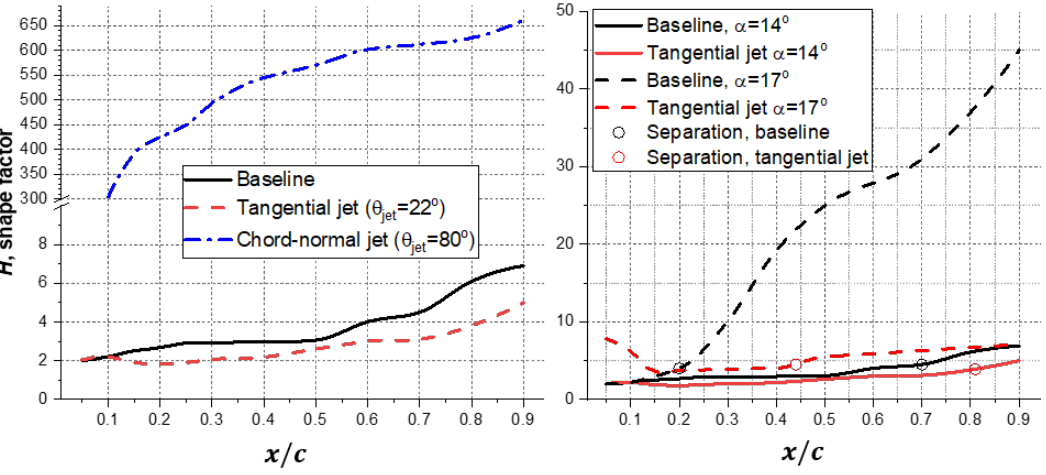
Figure 10. Shape factor of the suction-side boundary layer on the OA209 airfoil with and without steady-blowing jets. Ma = 0.3, Re = 1.15 M, c µ = 0.06 at α = 14 ◦ and 17 ◦ .